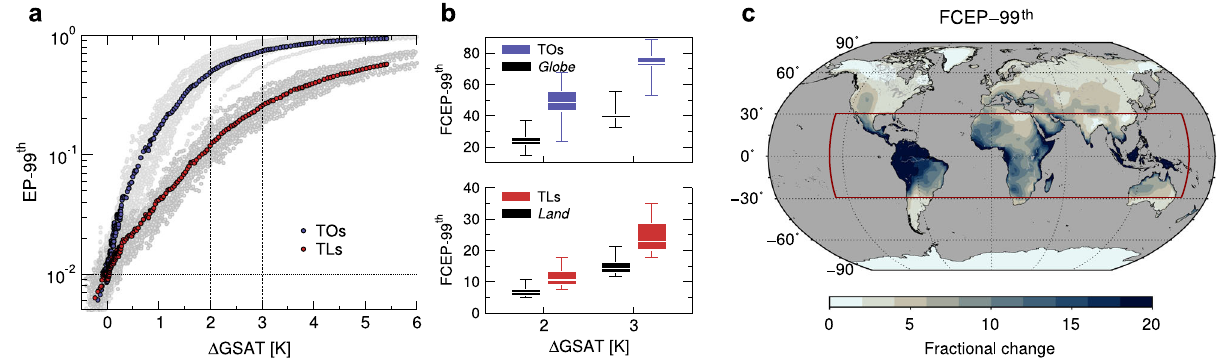
Fig. 8 | Tropical changes in hot day probabilities. a Multimodel hot-day prob- abilities (exceedance probabilities EP -99 th ) averaged over tropical oceans (TOs, non-land grid points in 30S-30N) and tropical lands (TLs, land-only grid points in 30S-30N),asa function ofchangesin global-meansurface air temperature(GSAT). Gray dots denote the intermodel spread. b Distributions of fractional changes in